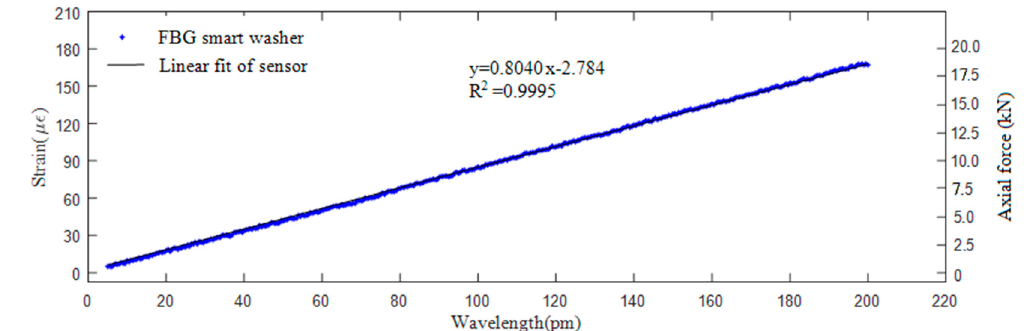
Figure 5. Calibration results of the smart washer.